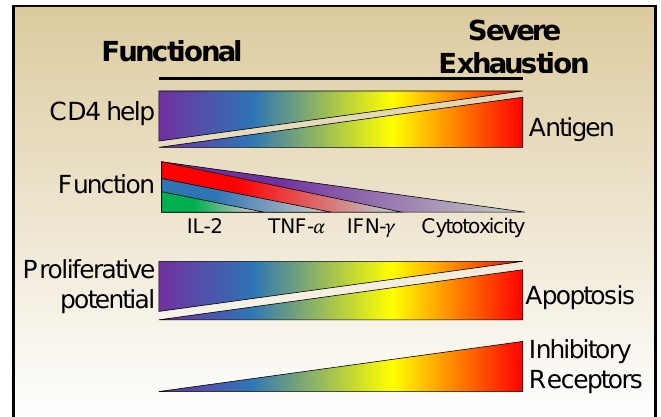
Figure 1. CD8 T cell exhaustion develops in a progressive manner as cardinal T cell effector functions are lost. Ineffective CD4 T cell help and sustained antigenic activation lead to the erosion of effector activities and can ultimately result in apoptosis. The severity of CD8 T cell exhaustion is reflected and exacerbated by the expression of multiple inhibitory receptors which further diminish functional